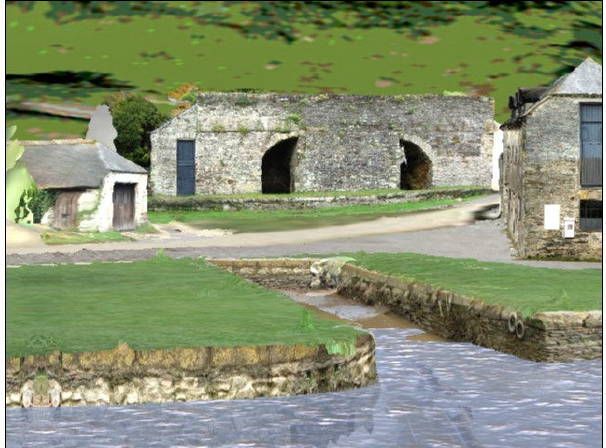
Figure 5 A rendered still from the camera view in 3DS